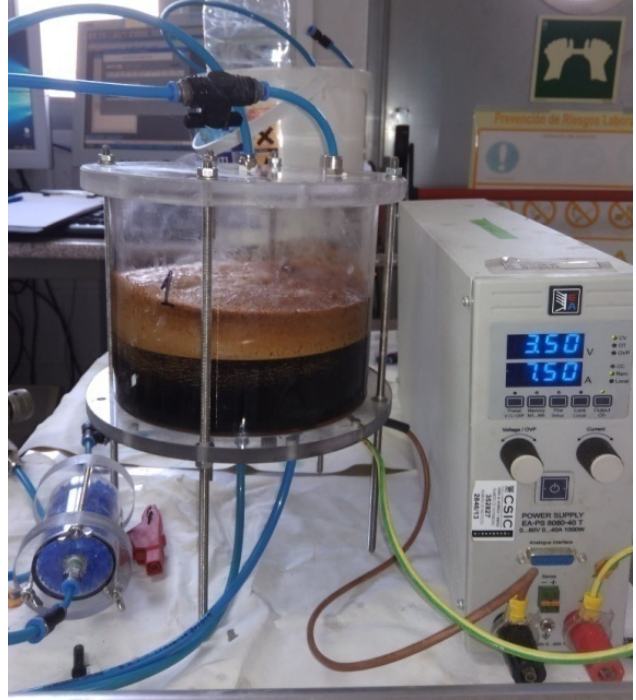
Figure 4. Single cavity of self-designed electrolyzer.